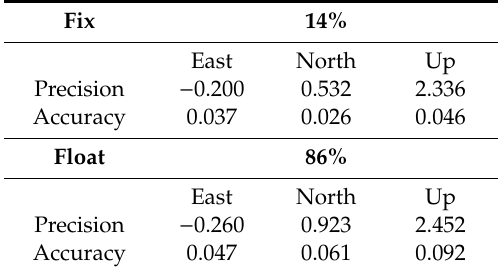
Table 13. Real-time positioning results using Samsung S8 + receiver and a session length equal to 5 min. Values in meters. Fix 14% East North Up Precision −